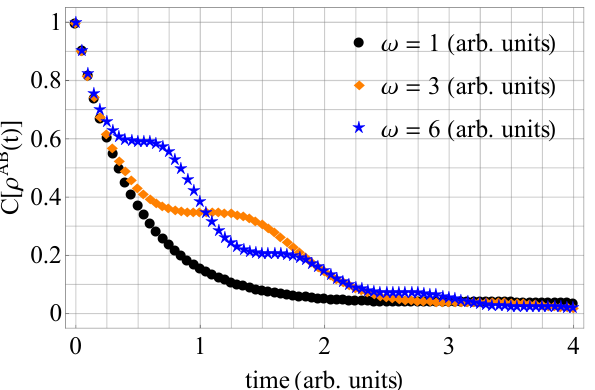
Figure 3. Concurrence, C [ ρ AB ( t )] , of the two-qubit density matrix with the initial state (15) for three values of ω